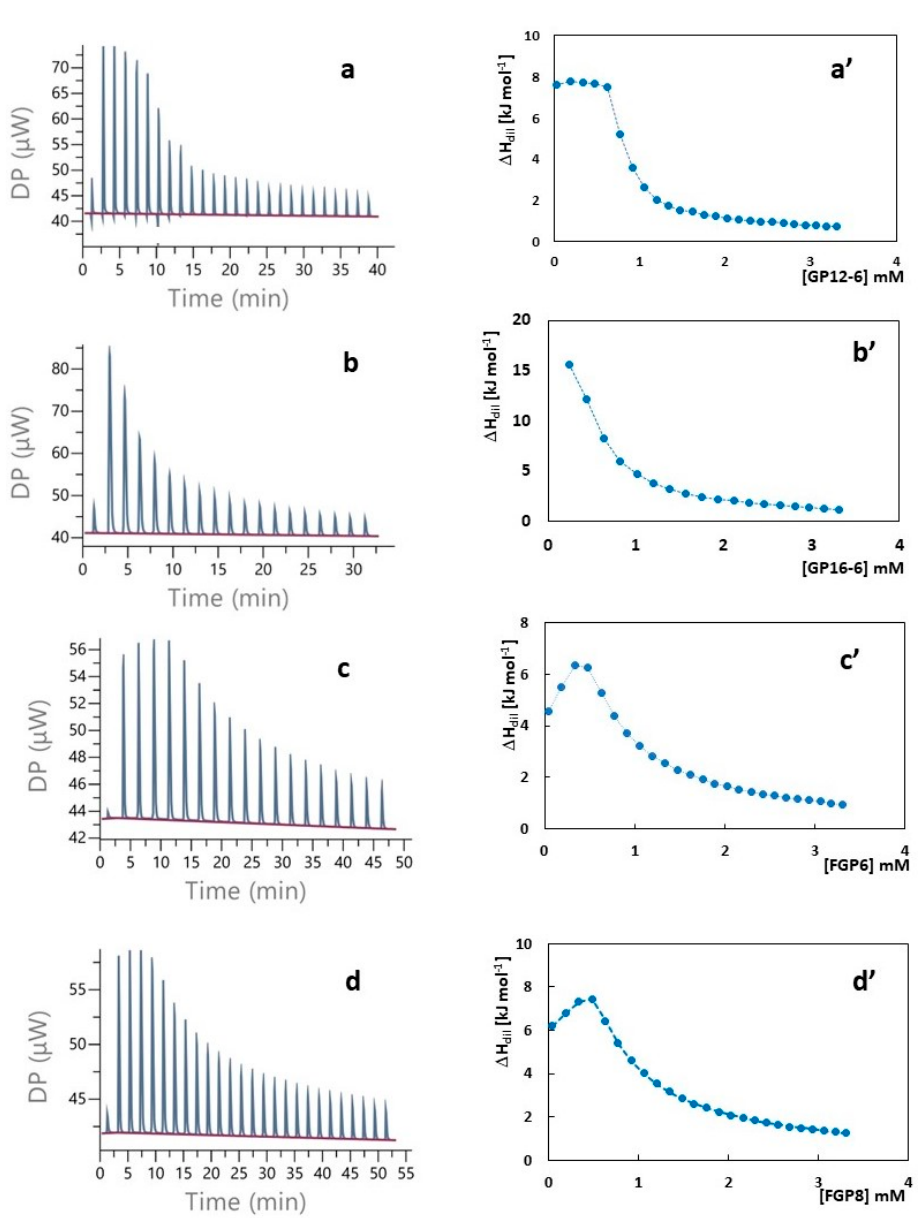
Figure 1. Heat rate ( µ W) vs. time profiles obtained by injecting a 20 mM surfactant solution into a 200 µ L reaction cell filled with water and (specified by a single quote mark) the dependence of the dilution enthalpy change vs. surfactant concentration in the reaction cell for: ( a ) GP12_6; ( b ) GP16_6; ( c ) FGP6; ( d )